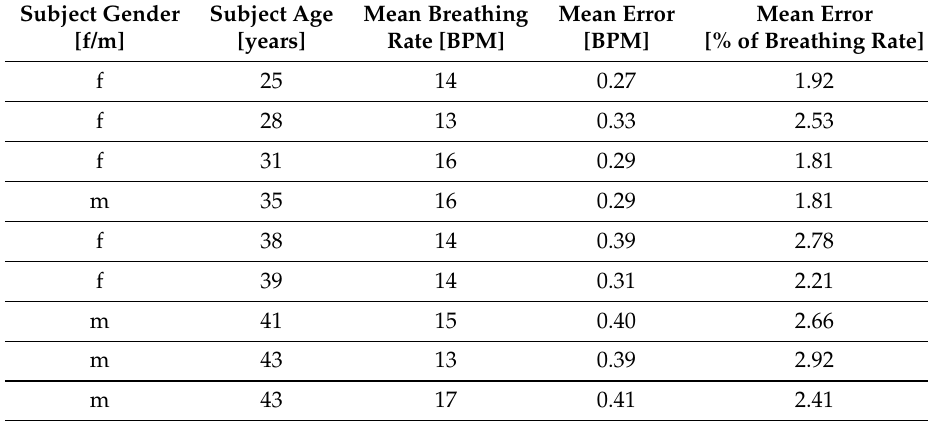
Table 3. Experiments results.